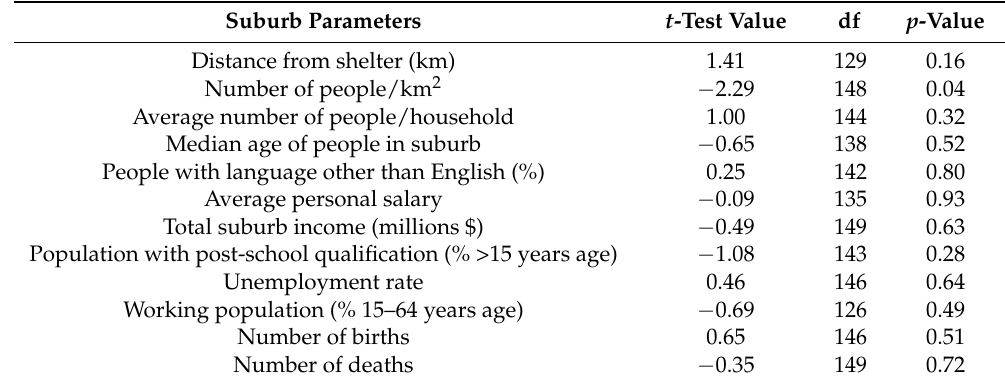
Table 4. Student t -test results for difference between 12 Western Australian suburb statistics [23] and cat adoption fee. No result is significant after sequential Bonferroni correction.